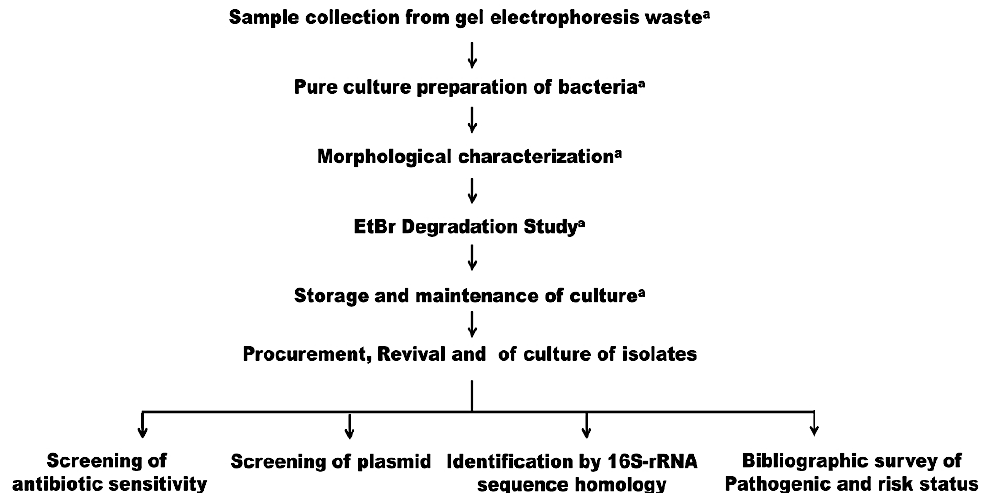
Figure 1. An outline of the work performed with respect to BR3 and BR4. a represents the work reported earlier reported earlier [13].